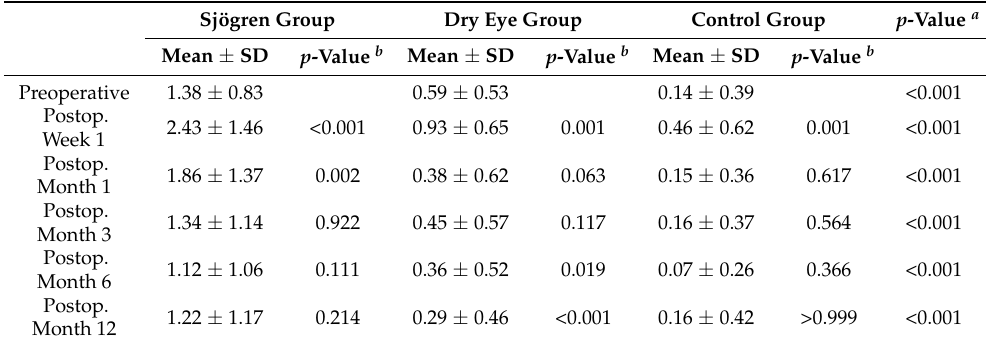
Table 2. Preoperative and Postoperative OSSs.